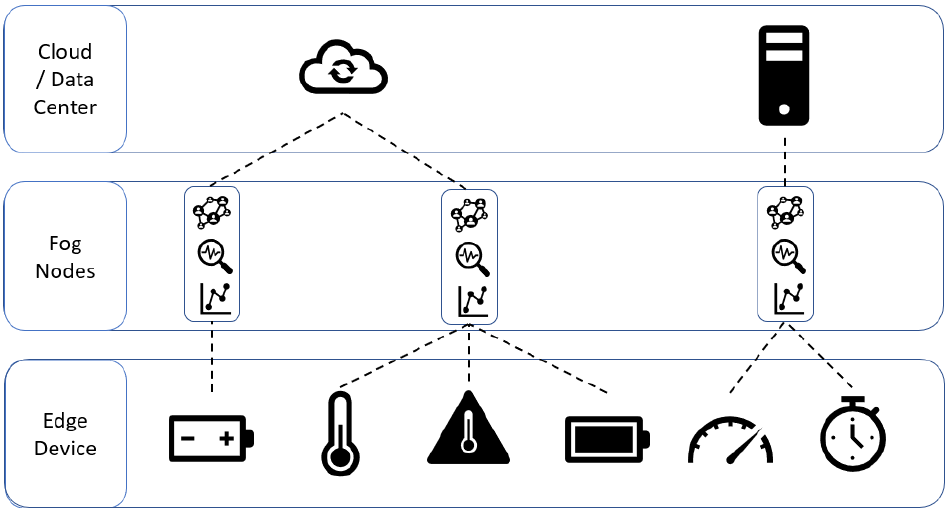
Figure 3. Multi-layered IoT infrastructure.